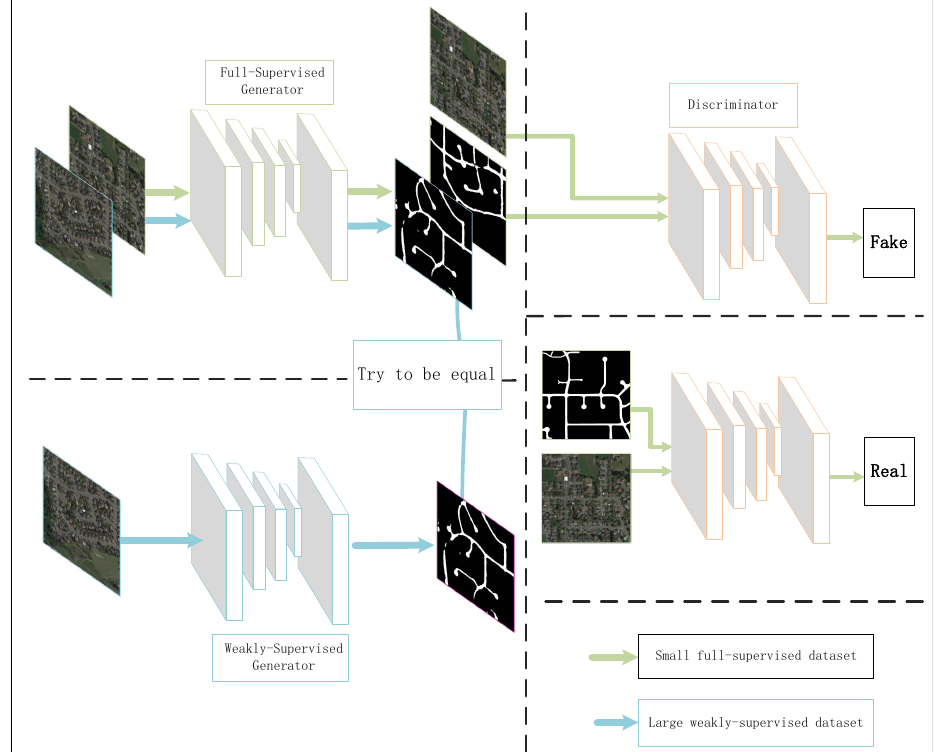
Figure 2. Overall framework of the proposed approach.